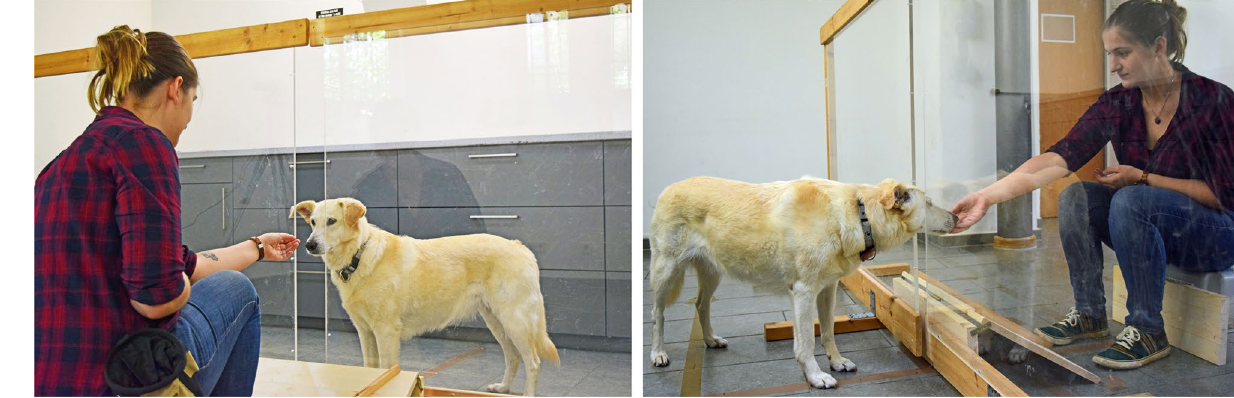
Figure 4. Experimental set-up.